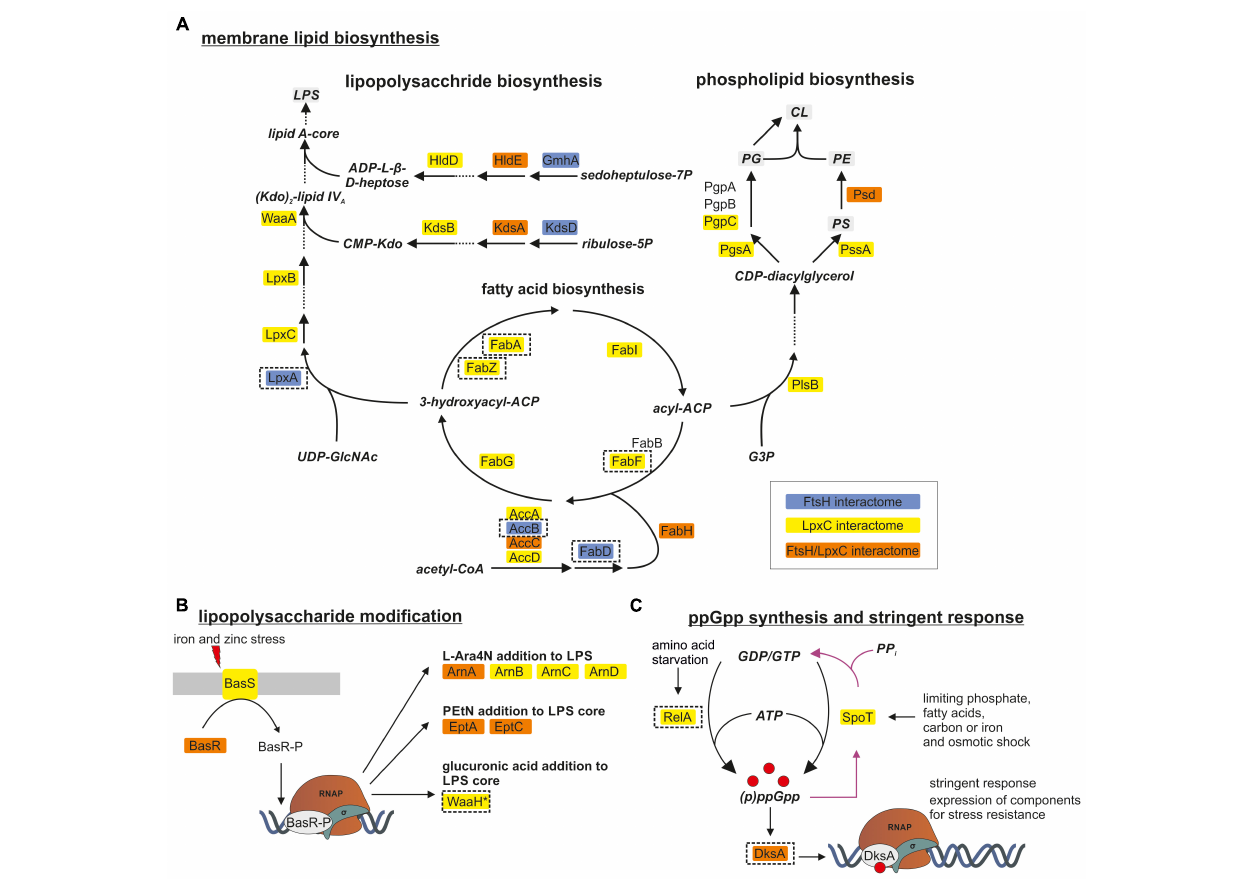
FIGURE 3 | FtsH and LpxC are strongly associated with proteins involved in membrane lipid biosynthesis (A) , LPS modification (B) and synthesis of the alarmone ppGpp (C) . LPS and PL biosynthesis are closely connected since both need products from FAB. Proteins identified in one of the FtsH, LpxC or both interactomes are marked in blue, yellow and orange, respectively. Proteins selected for downstream experiments are boxed with dashed lines. For a better overview, not all proteins of the illustrated pathways are shown (dashed arrows). CoA, coenzyme A; ACP, acyl carrier protein; UDP-GlcNAc, UDP-N-acetylglucosamine; Kdo, 2-keto-3-desoxy-octonat; ADP- L - β - D -heptose, ADP- L -glycero- β - D - manno -heptose; G3P, glycerol-3-phosphate; PG, phosphatidylglycerol; PC, phosphatidylcholine; PS, phosphatidylserine; CL, cardiolipin; PE/PEtN, phosphatidylethanolamine; L -Ara4N, 4-amino-4-deoxy- L